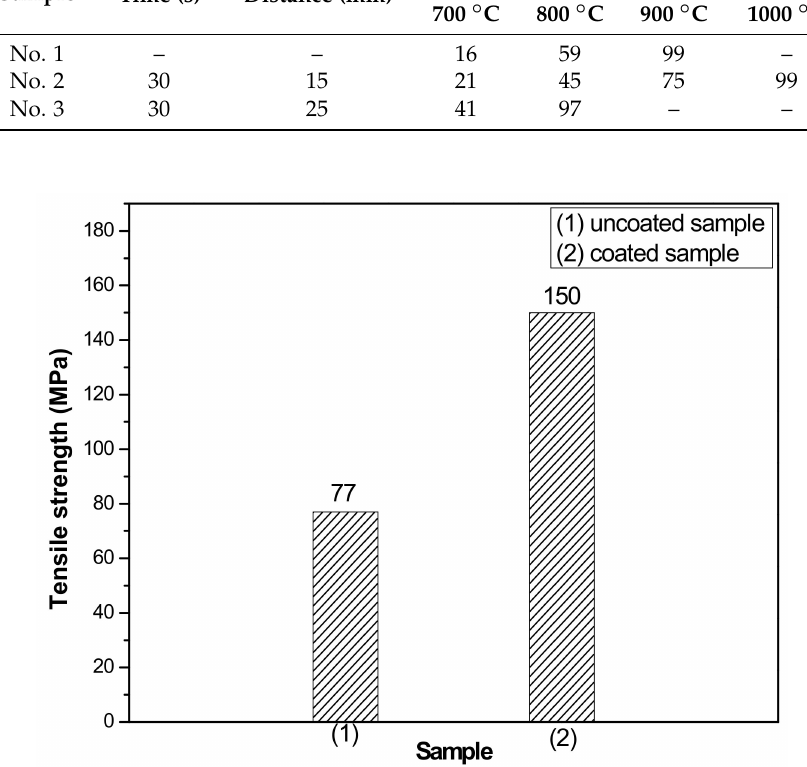
Figure 6. Tensile strength for heat-treated bare and the SiO 2 /SiC-coated sample at deposition time 30 s and spraying distance 15